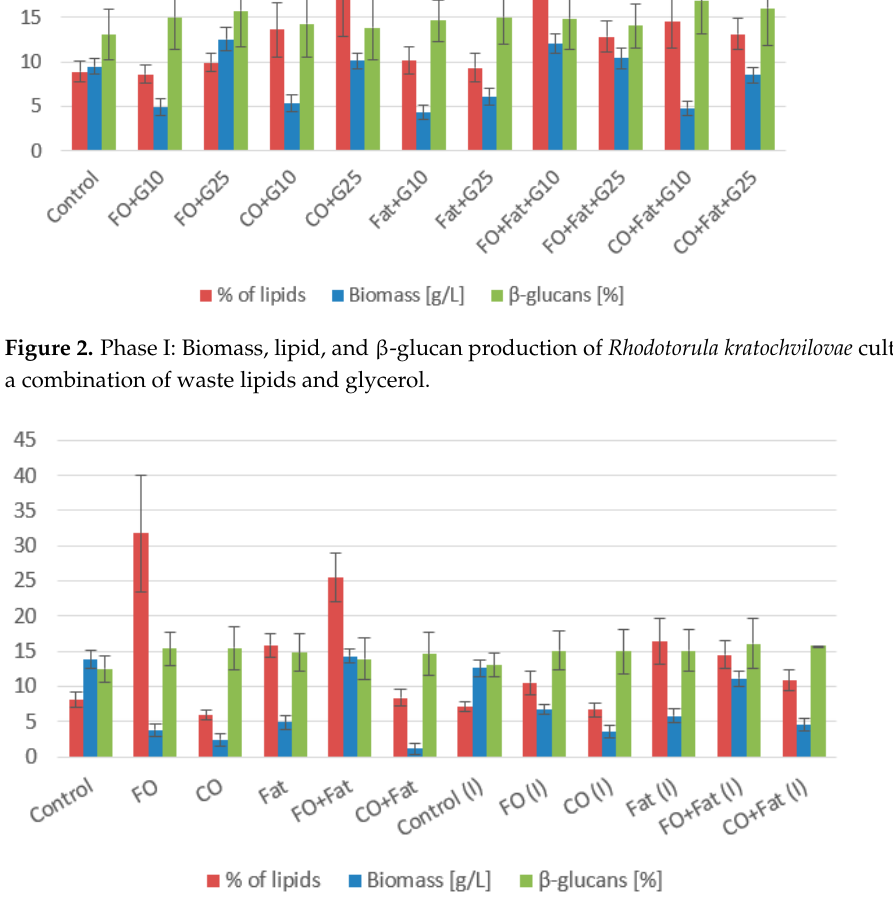
Figure 3. Phase II: Biomass, lipid, and β -glucan production of Rhodotorula kratochvilovae cultivated on waste lipid media with and without lipase induction. Table 3. HPLC analysis of Phase II screening cultivations Rhodotorula kratochvilovae cultivated on waste lipid media with and without lipase induction. Productions are listed in mg/g of cell dry weight.